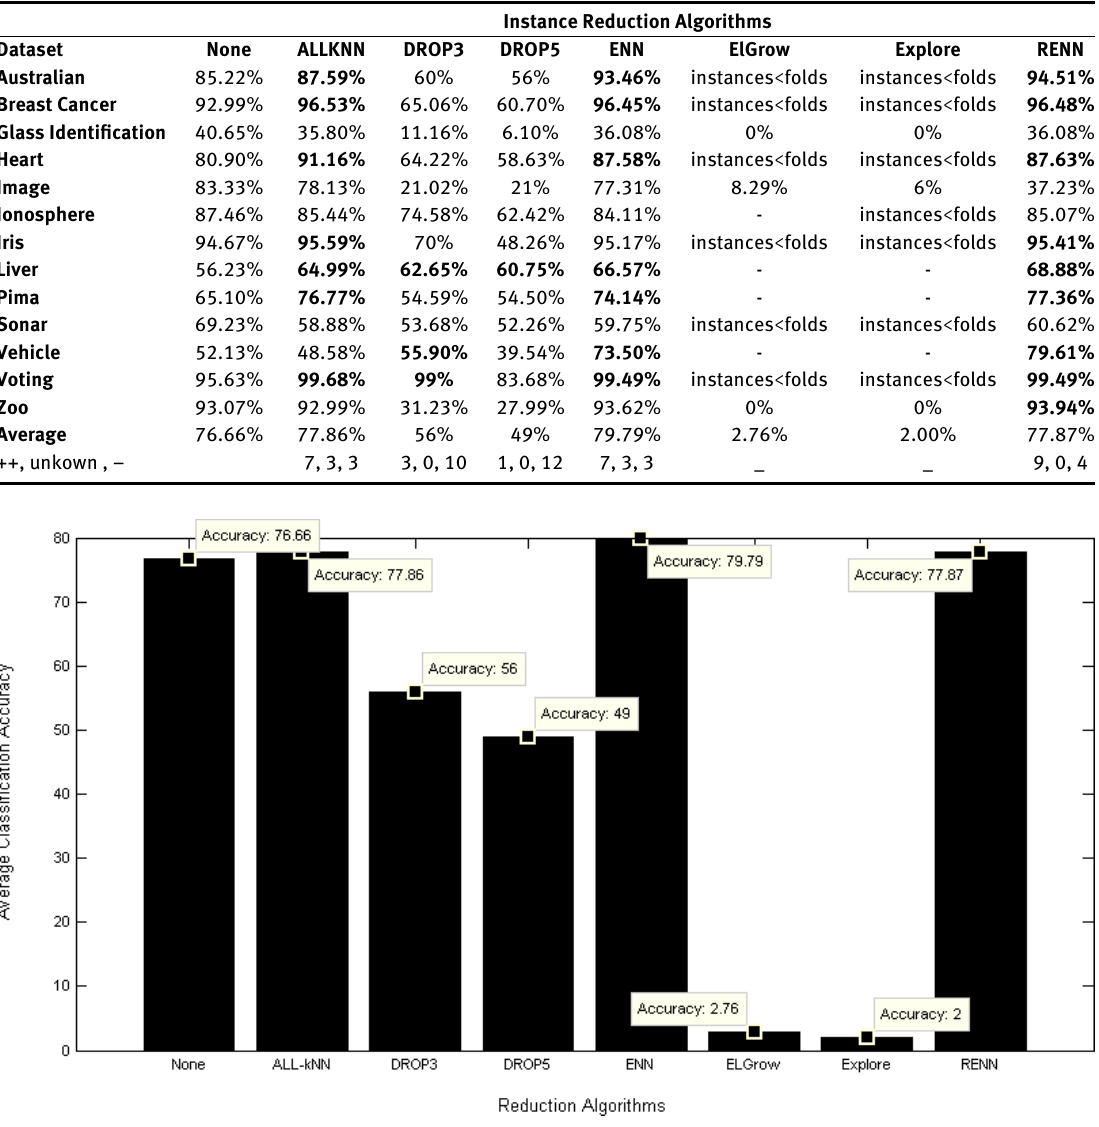
Figure 5: Average Classification Accuracy for Pruned Trees With 0% Noise